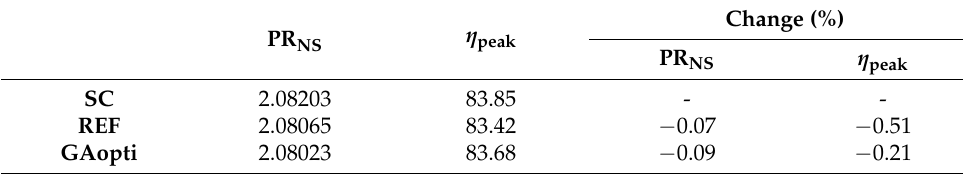
Table 5. Changes in pressure ratio and adiabatic efficiency by optimization.